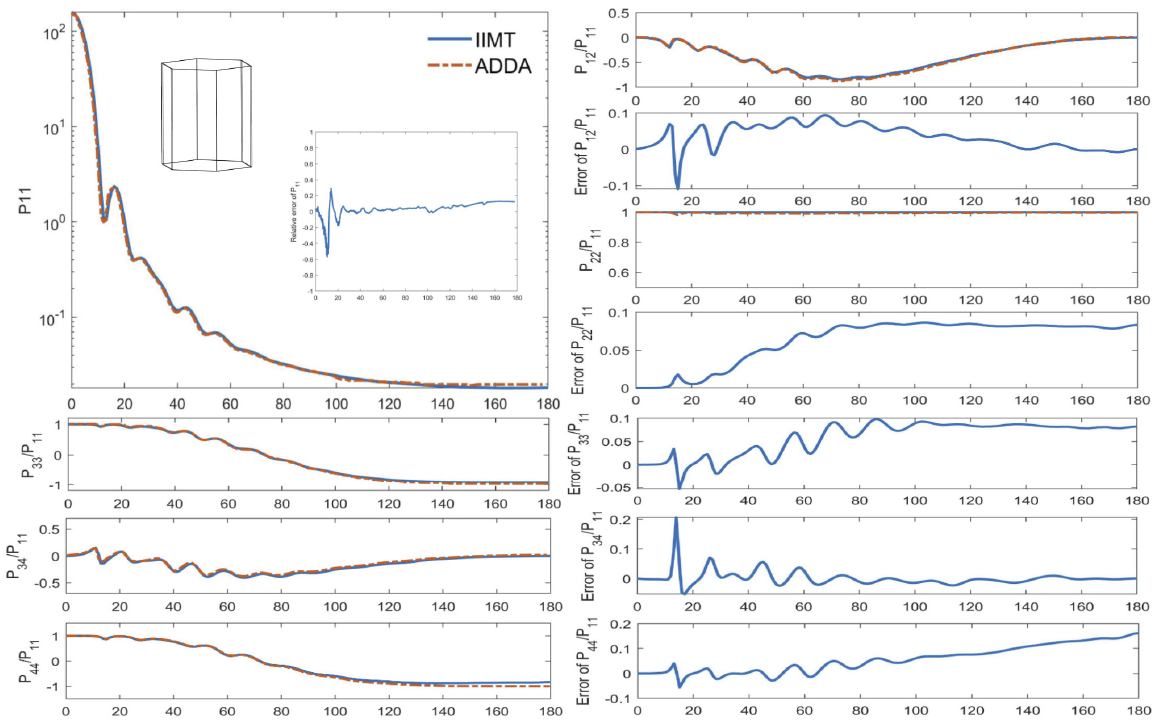
Figure 7. The phase matrices and their errors calculated by the IIM T − matrix method and ADDA methods for small hexagonal prism particles with random orientations. The abscissa is the scattering angle. The solid line is the IIM T − matrix method and the dashed is ADDA model. The errors of P 12 /P 11 , P 22 /P 11 , P 33 /P 11 , P 34 /P 11 and P 44 /P 11 are absolute errors. Table 2. The integral scattering properties of the hexagonal prism particles calculated by IIM T matrix and ADDA methods.